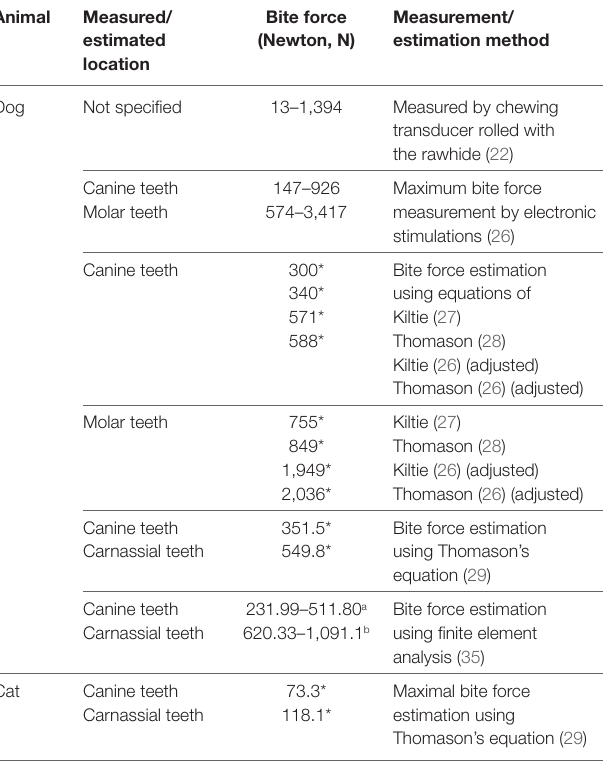
TaBle 1 | Studies on the bite force measurement/estimation in dogs and